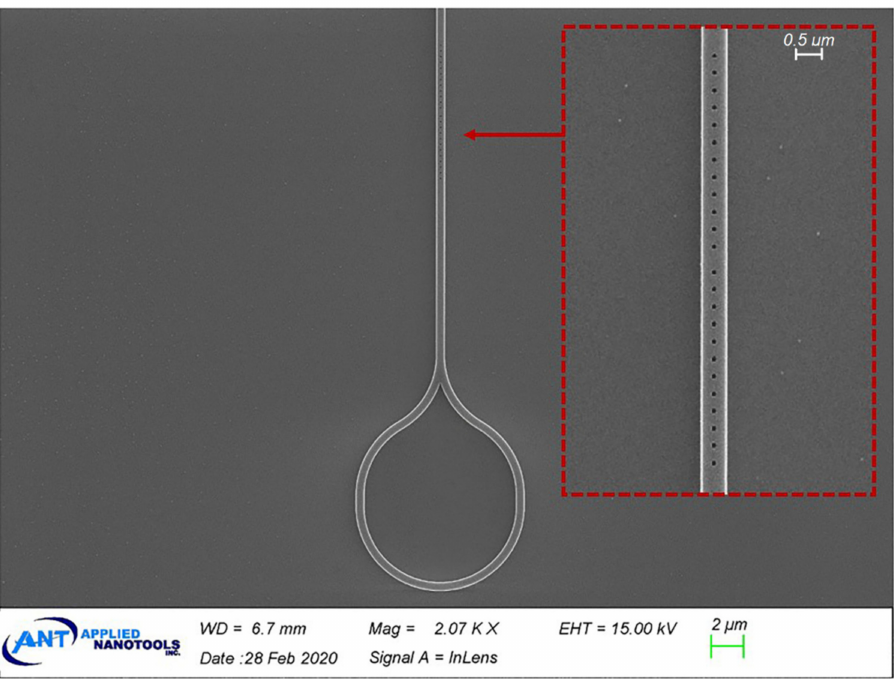
Figure 10. SEM image of the fabricated device. For the measurement, an Agilent 81,600B tunable laser source (TLS) is used as the light source, and an Agilent 81,635A optical power sensor is used as the output sensor. The transmission results are shown in Figure 11. The peak is at − 37 dB. This transmission includes the insertion loss of grating coupler times 2 and the 50% light separation from the Y-branch, resulting in about a 3 dB drop. The transmission includes the grating coupler insertion loss. There is a bit of shift at the peak wavelength from the simulation because of the usage of the 2.5D FDTD method. By comparing the FWHM linewidth of the experimental transmission with the simulated one, the Q-factor of the experimental results is estimated to be around 4083. We use the FWHM linewidth comparison to estimate the Q-factor of the experimental result because the Lumerical Q-factor monitor uses a more complex formula than the simpler Q = f R /FWHM formula to calculate the